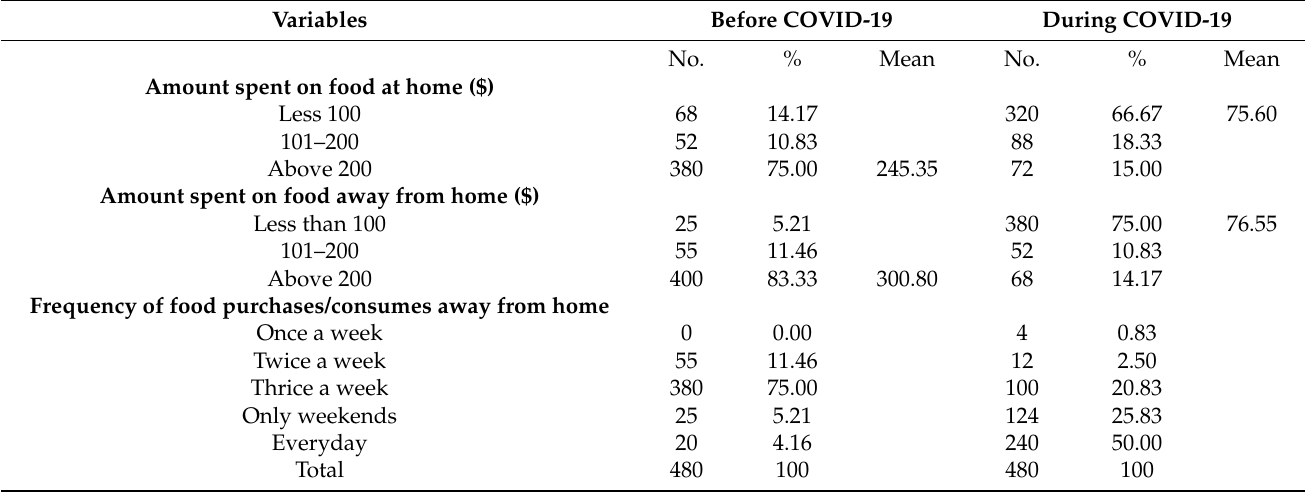
Table 7. Food expenditure pattern of the households before and during